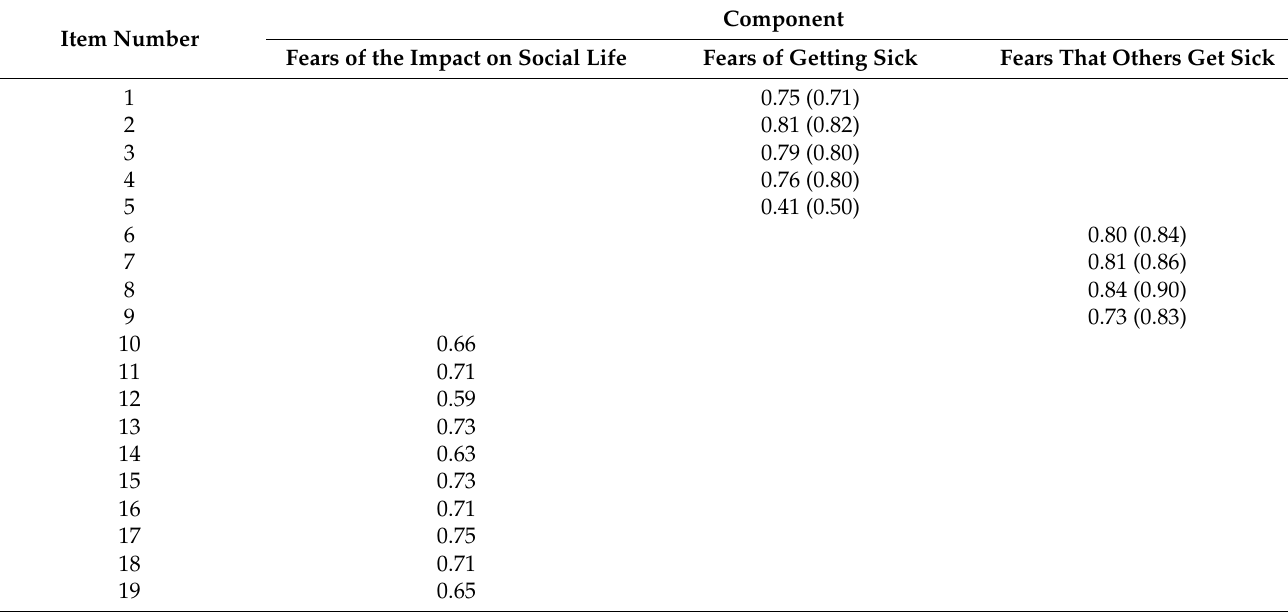
Table 6. Factor analysis for FIVE items 1–19 and